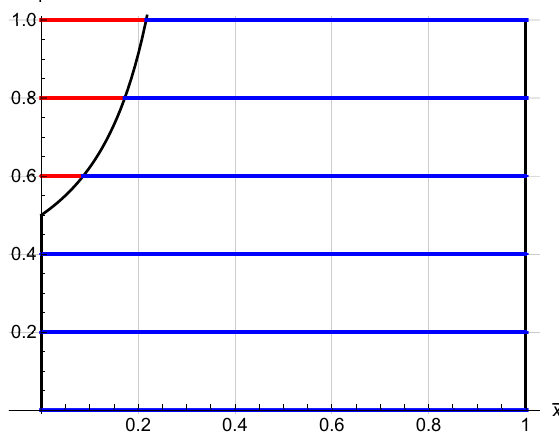
Figure 15. Potential distribution when there is a coupling between the first and second modes.